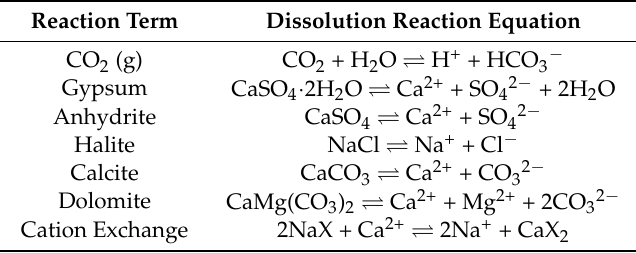
Table 1. Chemical reaction considering in PHREEQC